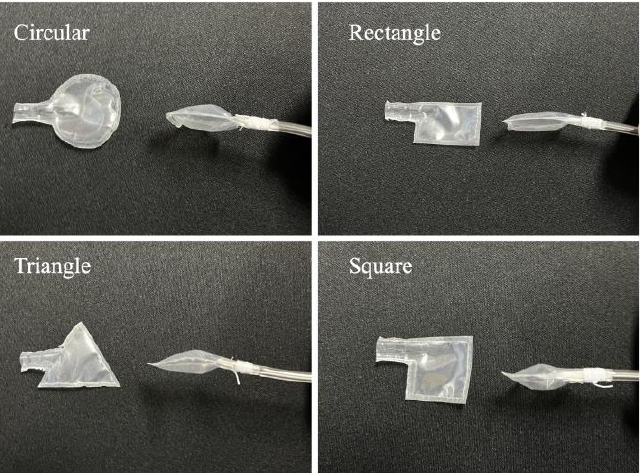
Figure 6. Four shapes were used in the pressure presentation experiments. In each figure, the left side shows the shape of the actuator (side view), and the right side shows the inflated actuator (top view). Table 2 shows the number of correct answers as to which actuators were inflated; the same results are graphically presented in Figure 7. In Table 2, F ave and M ave are the